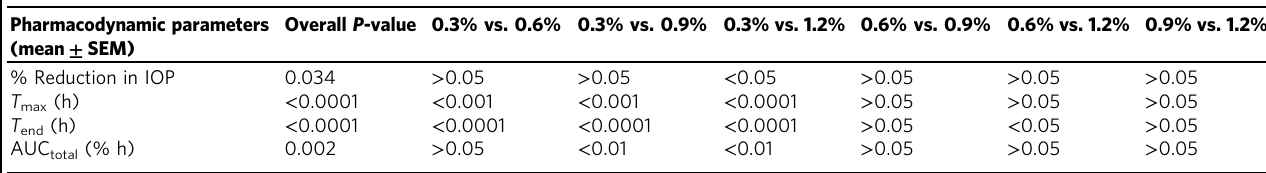
Overall P -value represents the outcome of the one-way ANOVA analysis. Individual P -values represent the outcome of Tukey – Kramer multiple comparisons tests. AUC total (% h) area under the curve in percent IOP reduction x hours, T end (h) time to end of response in hours, T max (h) time to maximum response in hours